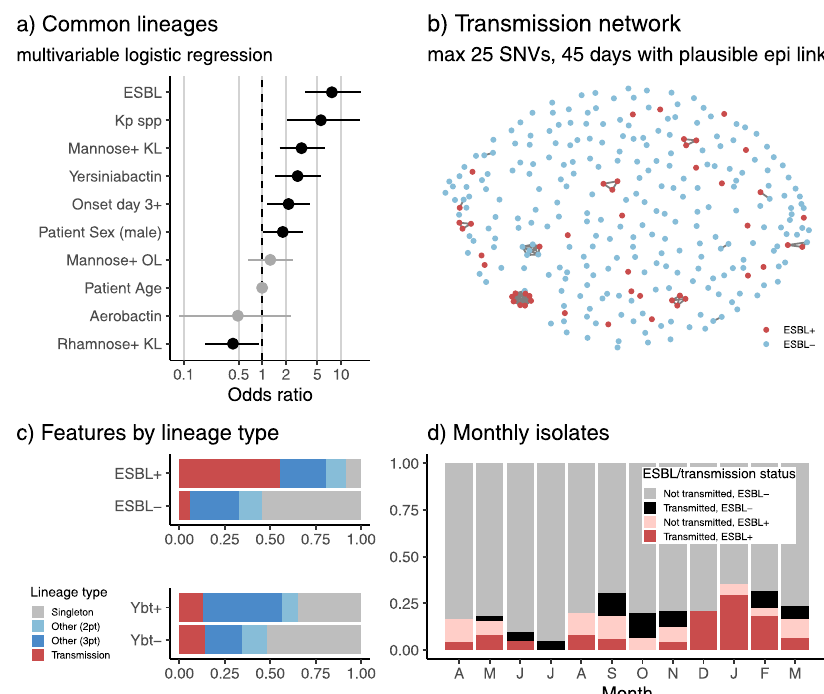
Fig. 6 Features of common lineages, and contribution of common and transmitted lineages to infection burden. a Genetic and patient characteristics associated with common lineages (identi fi ed in ≥ 3 patients), across n = 294 unique infection episodes. Circles indicate odds ratios estimated in a single multivariable logistic regression model with all 10 predictors; lines indicate 95% con fi dence intervals for those odds ratios; unadjusted p-values are shown, signi fi cant ( p < 0.05) associations are coloured black. Binary variables: ESBL (extended spectrum beta-lactamase detected); Kp spp ( K.